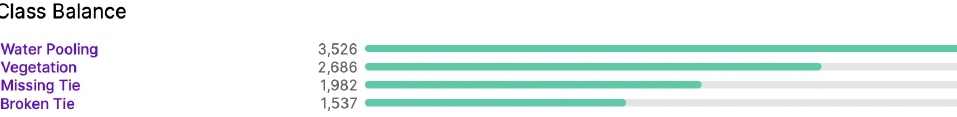
Figure 11. Class